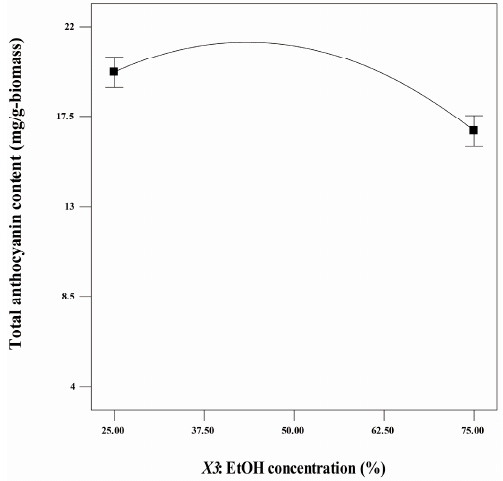
Figure 2. Line plot explaining the effect of EtOH concentration on total anthocyanin content.